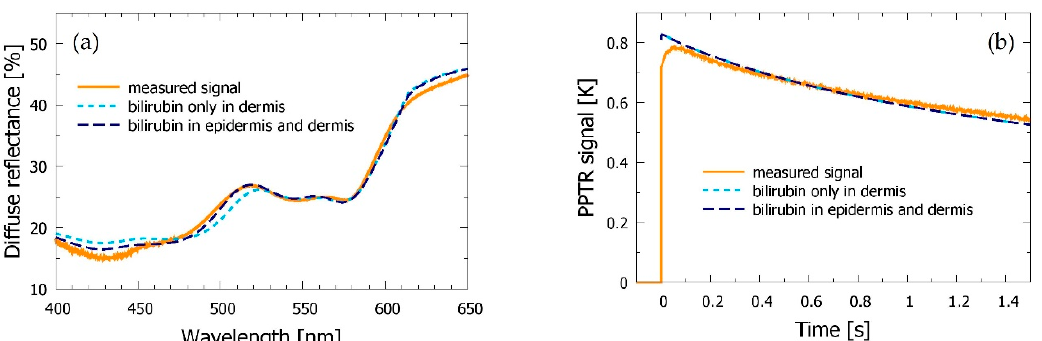
Figure 5. ( a ) DRS and ( b ) PPTR signals acquired form the bruise in subject a at 119 h after injury (orange lines). Dashed lines present the best-fitting model predictions when bilirubin is allowed only in the dermis (light blue), and in both epidermis and dermis (dark blue).